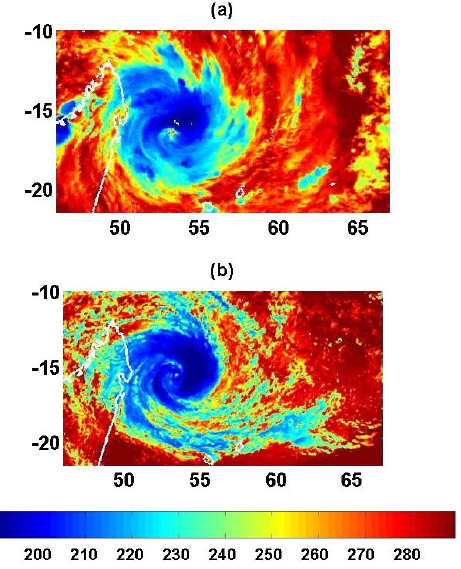
Fig. 4. Brightness temperature (K) from (a) IR channel of Meteosat- 7 and (b) Meso-NH outputs on 16 February 2008 at 00:00UTC.